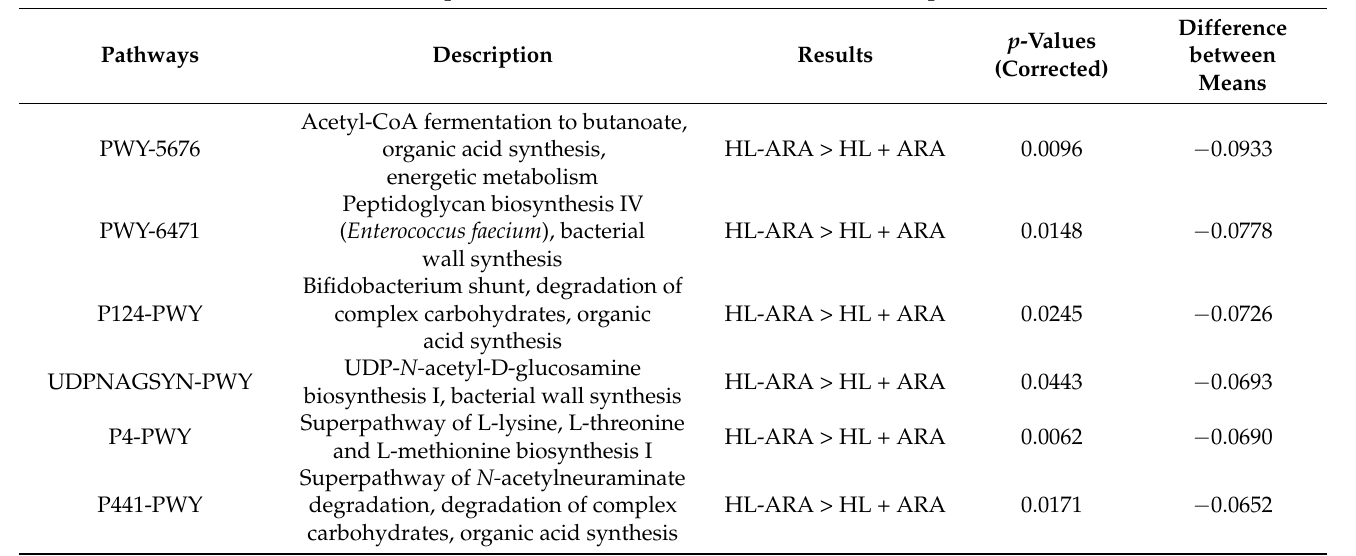
than in the HL-ARA group and 18 were more abundant. Among the most represented genes in the HL-ARA group, some are involved in amino-acid and bacterial wall synthe- sis, while the most represented in the HL + ARA group are involved in the synthesis of folates, flavins, and B1 and B6 synthesis (Table 4).